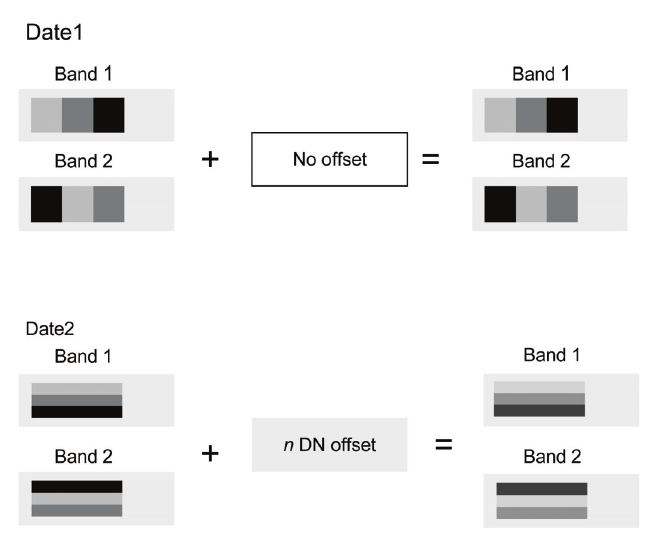
Figure 4. Overview of the construction of the simulated data with radiometric error (offset) between dates. In this example, the DN values for date 2 are offset by a specified amount, n